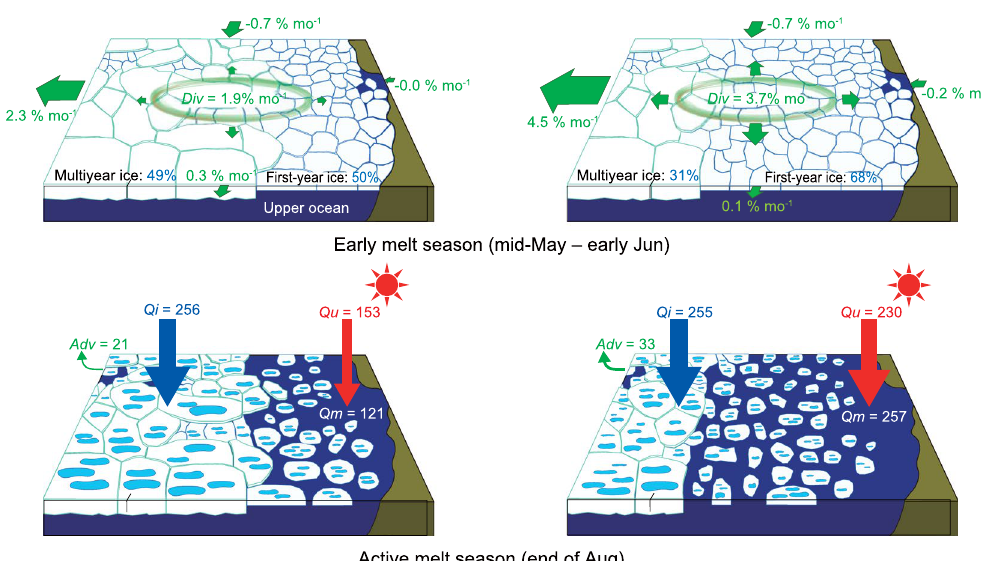
Figure 4. Schematic of ice and heat budgets during seasonal ice retreat. Mean ice conditions and heat budgets for the two periods ( a ) 1979–1999 and ( b ) 2000–2014 are shown. Divergent ice motion in the early melt season induces a small reduction in ice concentration (upper panel). A key finding is that although the direct contribution of doubled divergent ice motion after 2000 to the ice concentration reduction is small, this trigger accelerates ice melt through the enhanced solar heat input over the open water fraction (ice-ocean albedo feedback) until the end of August (lower panel). All values in the lower panel are ones accumulated from May to August and standardized as heat per unit area (MJ m − 2 ), and the volume of ice is converted to the equivalent heat required for ice